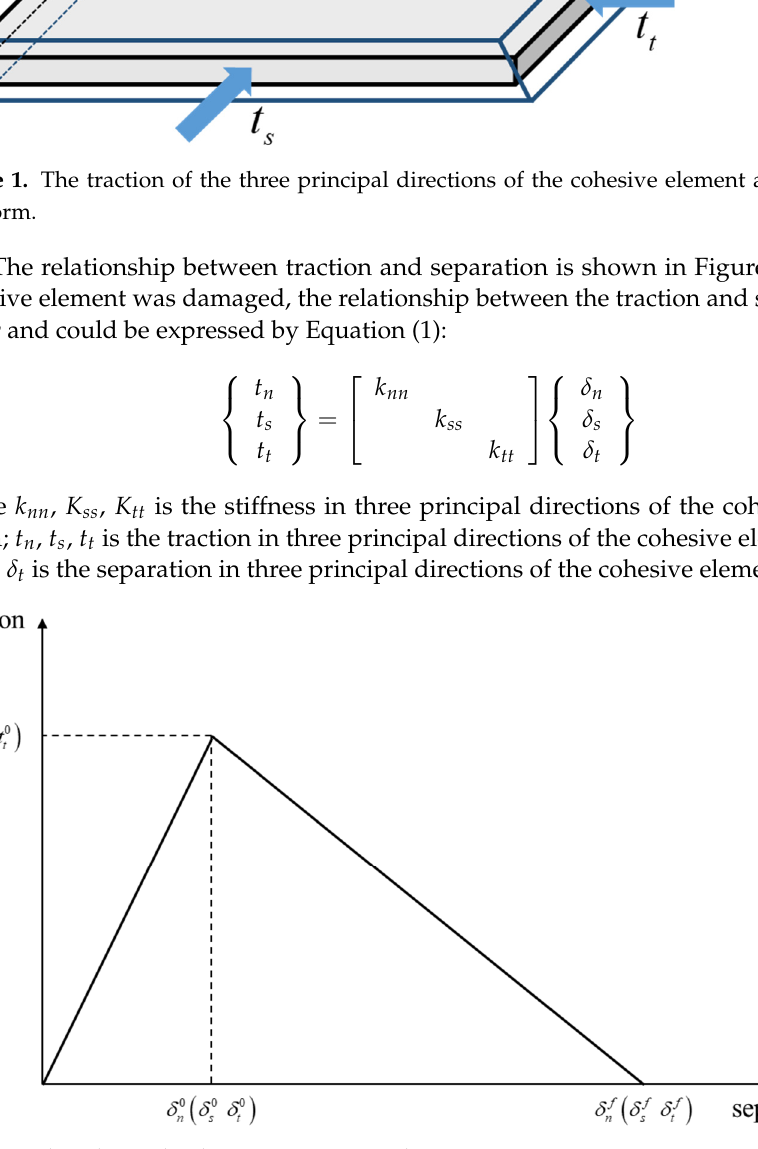
Figure 2. The relationship between traction and separation.